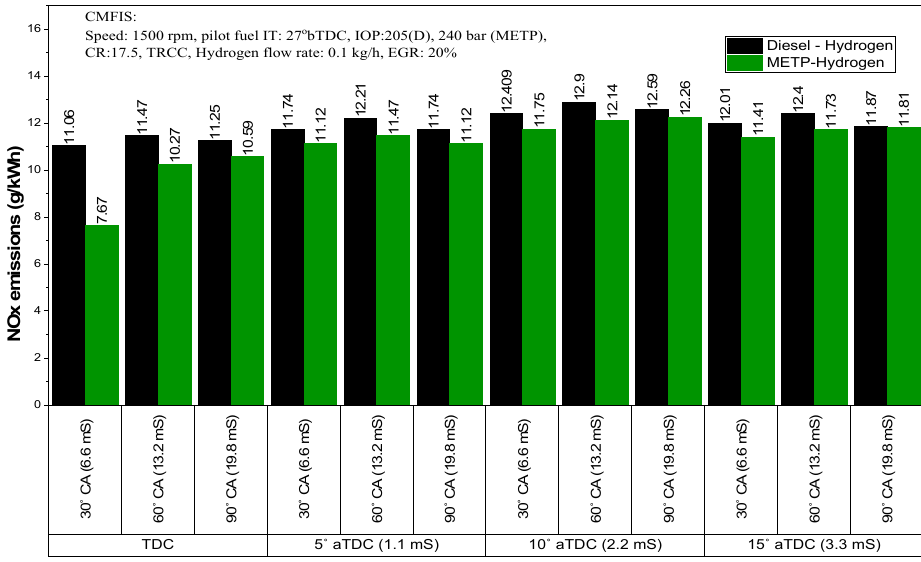
Figure 14. NOx for manifold injection of hydrogen in CMFIS based a dual-fuel engine.